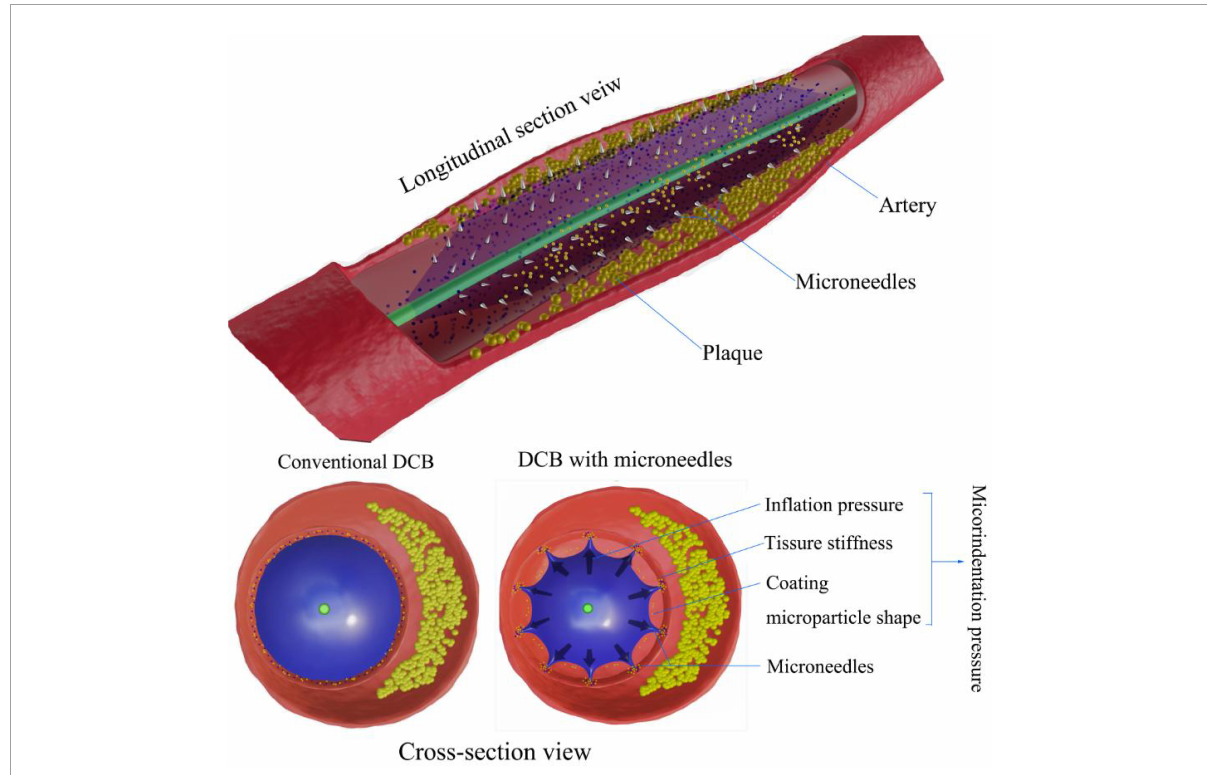
FIGURE3 Microindentation pressure on DCB drug delivery. Compared with conventional DCBs, microindentation pressure results from the combination of inflation pressure, coating particle shape, and tissue stiffness. Microneedles of DCBs enhance drug delivery by increasing contact pressure in micromode after full